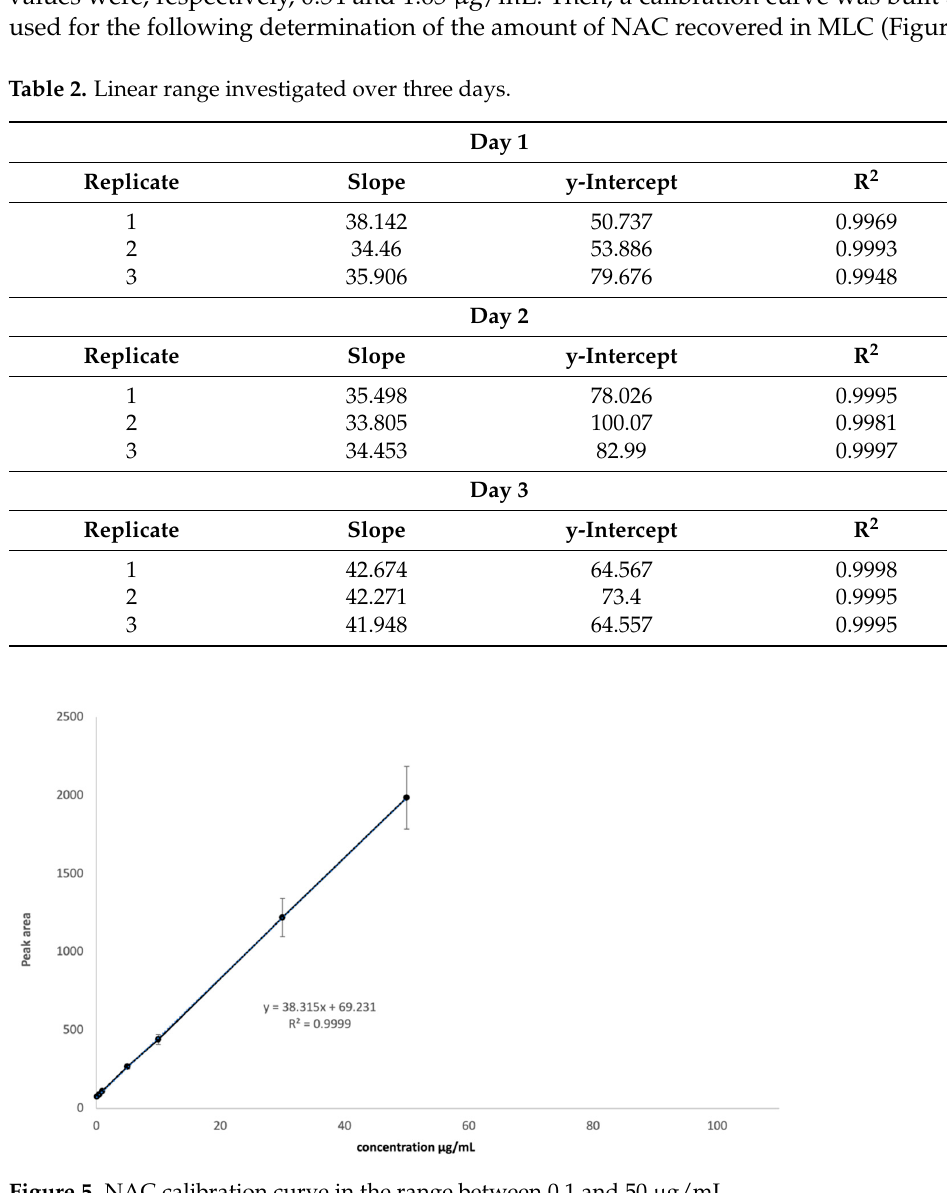
Figure 5. NAC calibration curve in the range between 0.1 and 50 μ